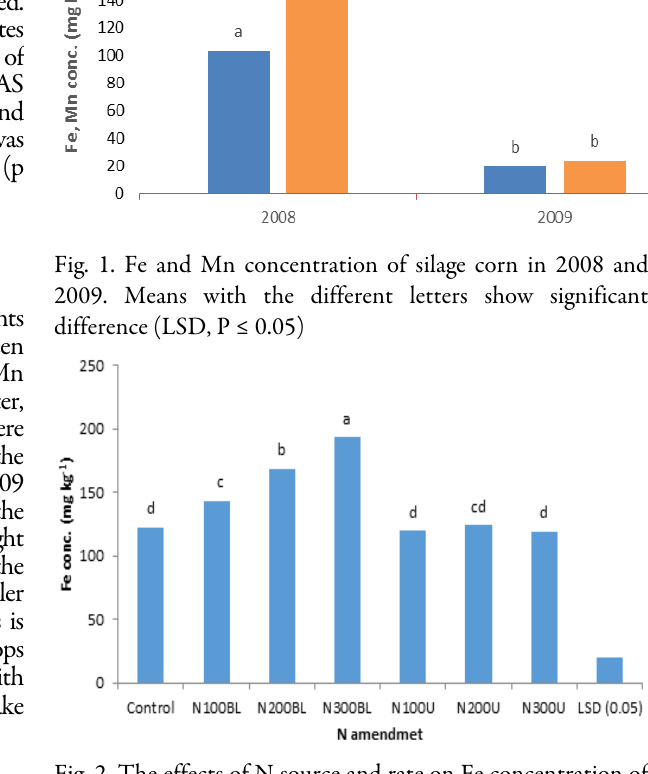
Fig. 2. The effects of N source and rate on Fe concentration of silage corn. Control: without chemical fertilizer and broiler litter; N , N , and N : 100, 200 and 300 kg ha -1 of N as 100U 200U 300U urea fertilizer, respectively; N , N , and N : 100, 200 100BL 200BL 300BL and 300 kg ha -1 of N as broiler litter, respectively. Means with the different letters show significant difference (LSD, P ≤